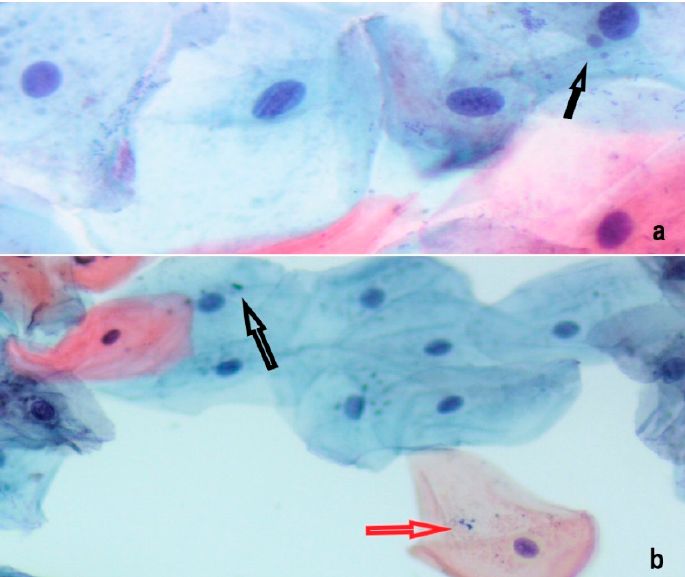
Figure 2. Epithelial cells containing 1 MN (black arrows) from ( a ) e-cigarette user (Pap stain, ×40) and ( b ) nonsmoker (Pap stain, ×20). Beside microorganisms, dye granules can be distinguished due to intense staining (red arrow).